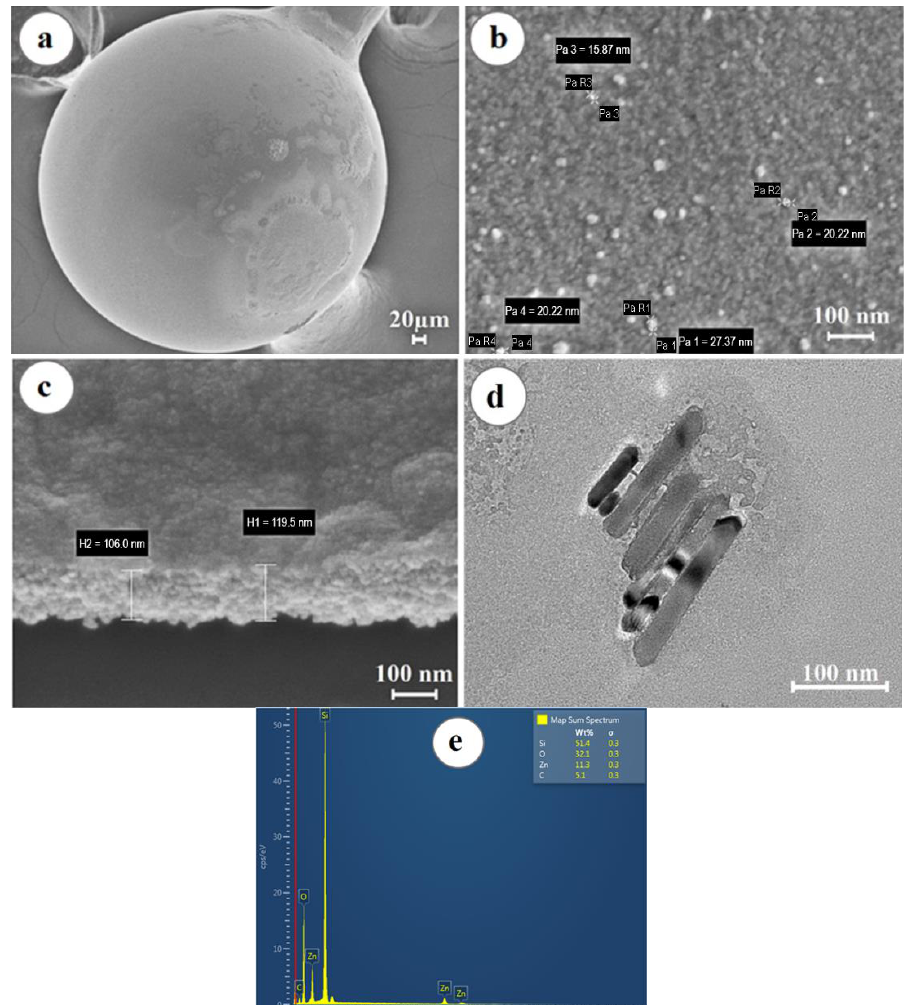
Figure 3. Morphological analysis of the surface of the ball resonator optical fiber coated with a ZnO layer: ( a ) SEM image of the optical fiber sensor showing its spherical shape and surface coating; ( b ) SEM image demonstrating the grain structure of the ZnO layer; ( c ) ZnO layer thickness on the surface of the optical fiber biosensor; ( d ) TEM image of ZnO; ( e ) EDS—surface analysis of the ball resonator optical fibers demonstrating the presence of Zn, O, C, and Si